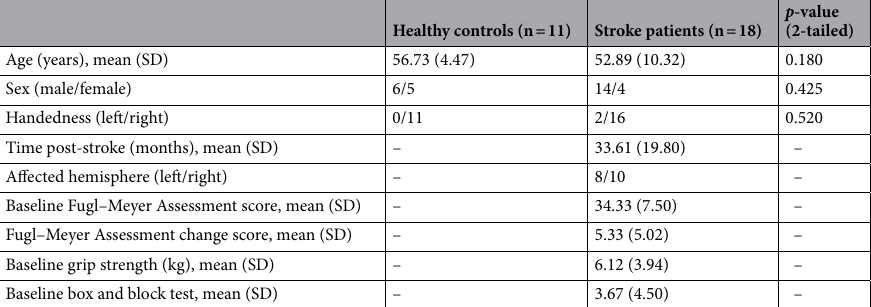
passive task. By visual inspecting of the task performance, the peak of each movement onset with attenuation of hand gripping pressure could be clearly identified, indicating that all stroke patients and healthy controls were able to perform the active tasks using either affected or unaffected hand. We additionally investigated whether patients and controls showed any differences in terms of achieving the target pressure per visual cue in the active motor tasks by dividing the number of trials meeting the target pressure by the total number of trials per par- ticipant. After performing two-sample t-tests, we did not find any group differences between healthy controls and stroke patients in both active tasks using affected or unaffected hand. For patients with stroke lesions in the right hemisphere, we flipped their MR images (lesion mask, task-free and task-based fMRI) to ensure that lesions were on the left side of the hemisphere. Thereafter, the left hemisphere was regarded as the ipsilesional hemisphere and right hemisphere was regarded as the contralesional hemisphere in stroke patients. For healthy controls, their MR images were not flipped. Accordingly, the right hand was treated as the affected hand and the left hand as the unaffected hand. This resulted in four motor task conditions ordered in decreasing demands: active-affected (AA), active-unaffected (AU), passive-affected (PA), and passive-unaffected (PU). Image acquisition. Participants were scanned in a 3 T Siemens Magnetom Trim Trio scanner with a 32-channel head array coil at the Clinical Imaging Research Center, Singapore 41 . The scan protocol included a T 1 -weighted magnetization prepared rapid gradient-echo (MPRAGE) sequence (inversion time = 900 ms, rep- etition time = 1900 ms, echo time = 2.5 ms, flip angle = 9 ° , field of view = 256 × 256 mm 2 , 176 sagittal slices, matrix size = 256 × 256, and voxel size = 1 mm 3 isotropic), a task-free T 2 *-weighted echo planar imaging (repetition time = 1750 ms, echo time = 30 ms, flip angle = 74°, field of view = 220 × 220 mm 2 , voxel size = 3.4 mm 3 isotropic, slice thickness = 3.4 mm, 33 axial slices), and four task-based T 2 *-weighted echo planar imaging (repetition time = 3000 ms, echo time = 30 ms, flip angle = 90°, field of view = 220 × 220 mm 2 , voxel size = 3.4 mm 3 isotropic, slice thickness = 3.4 mm, 42 axial slices).